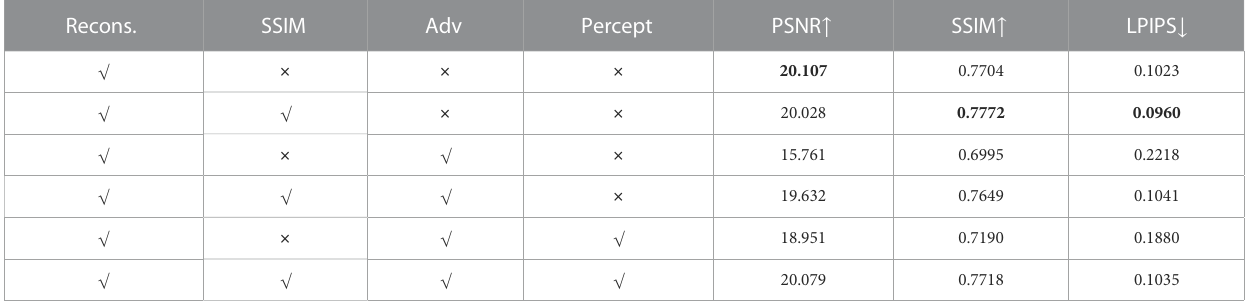
TABLE 1 Ablation study of diverse loss functions and corresponding image quality evaluations.